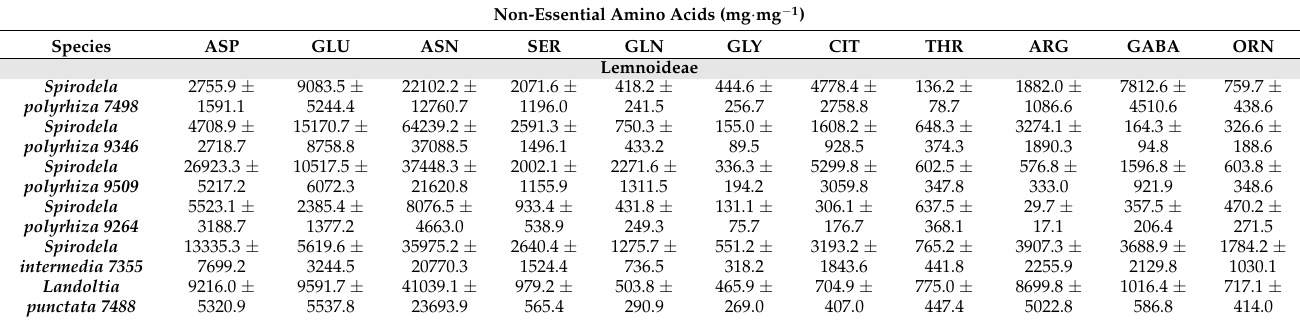
Table 5. Non-essential amino acids composition of 21 duckweeds ecotypes. Data represented in mg · mg − 1 dry weight by average ± standard error ( n = 3). ASP: aspartic acid, GLU: glutamic acid, ASN: asparagine, SER: serine, GLN: glutamine, CIT: citrulline, THR: threonine, GABA: Gamma- aminobutyric acid, and ORN: